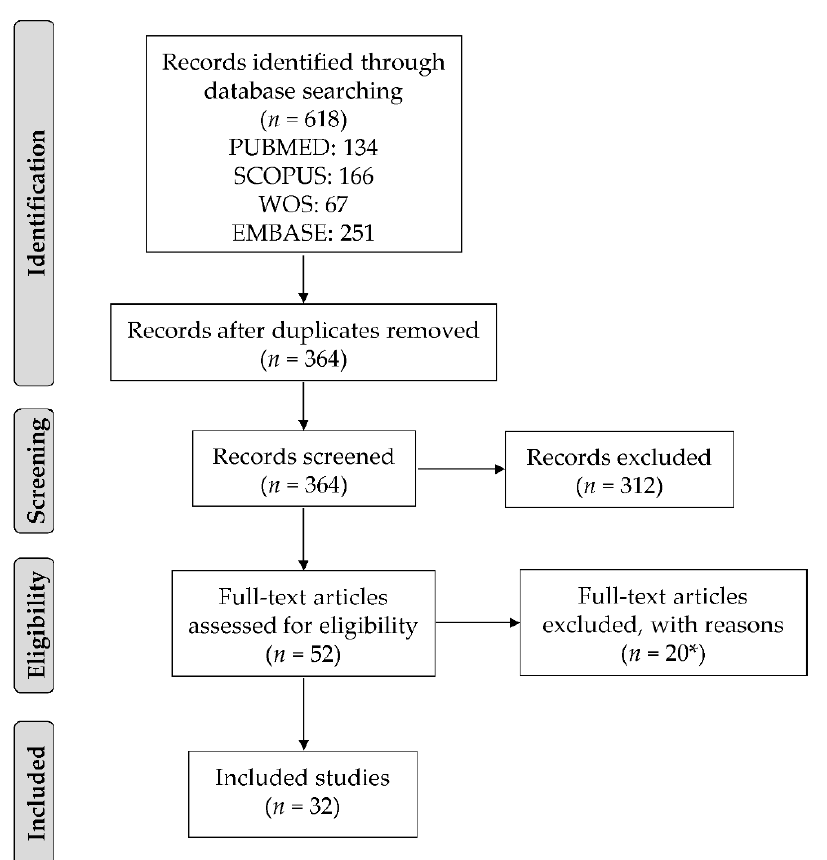
Figure 1. Flow diagram showing the study selection process. * Reasons for exclusion: reviews ( n = 2), abstracts ( n = 11), statistical analyses included singletons and twins together ( n = 1), different outcomes ( n = 3), twin mothers ( n = 1), adult twins ( n = 1), and no statistical analyses ( n = 1).